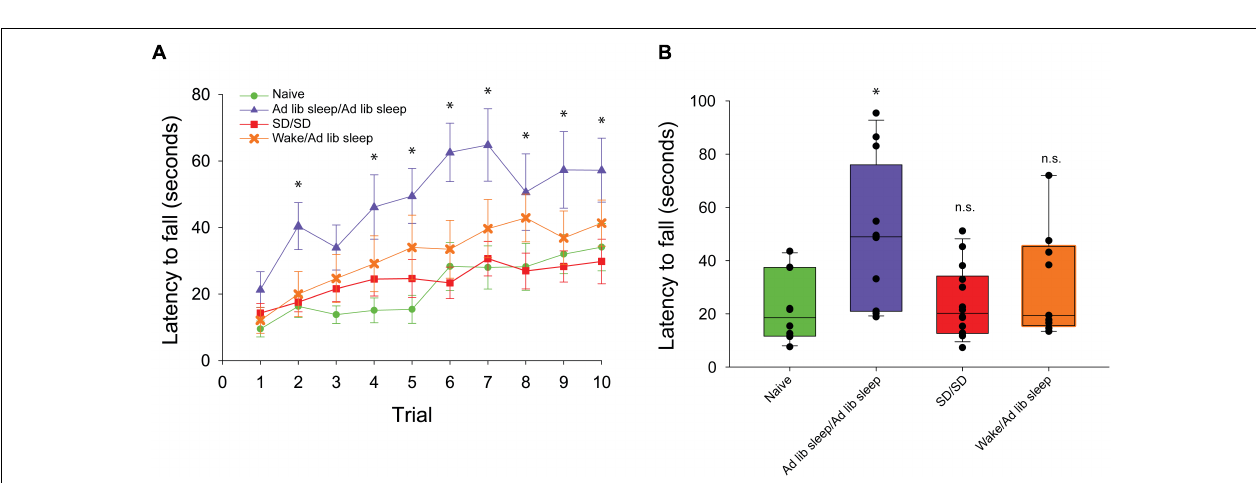
FIGURE 1 | Training and testing paradigms for motor gist learning. Timeline demonstrating the exclusive forward running template behavior [ F ] occurring beginning at ZT0 on two consecutive days followed by ad libitum sleep (A) or 10 h of acute sleep disruption (B) . Testing on exclusive backward running [ B ] occurs beginning at ZT0 on the third day. (C) Timeline demonstrating the exclusive forward running template behavior [ F ] occurring twice on day 1 beginning at ZT0 separated by 30 min of natural wake prior to testing on exclusive backward running [ B ] beginning at ZT0 on day 2.